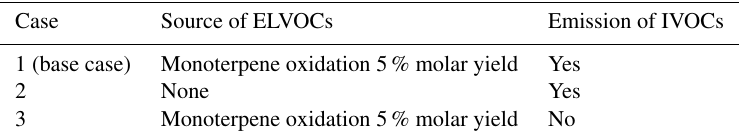
Table 1. Summary of parameters used in each